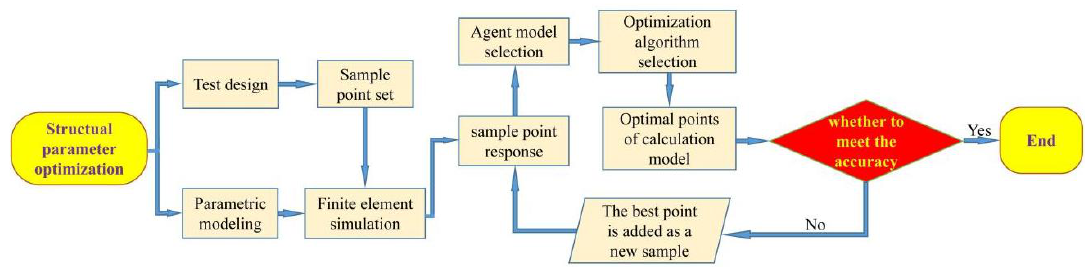
Figure 7. Steps of constructed surrogate model.